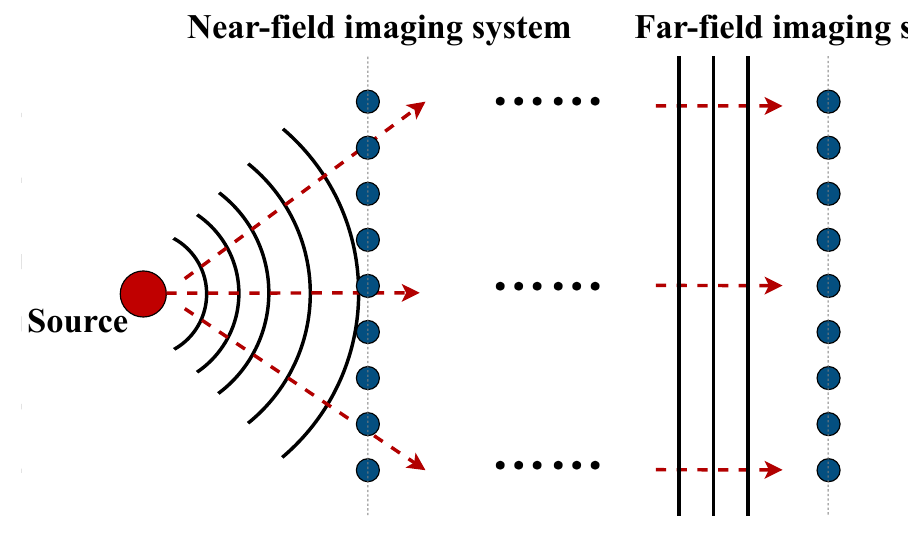
Figure 1. The target radiation signal wavefront